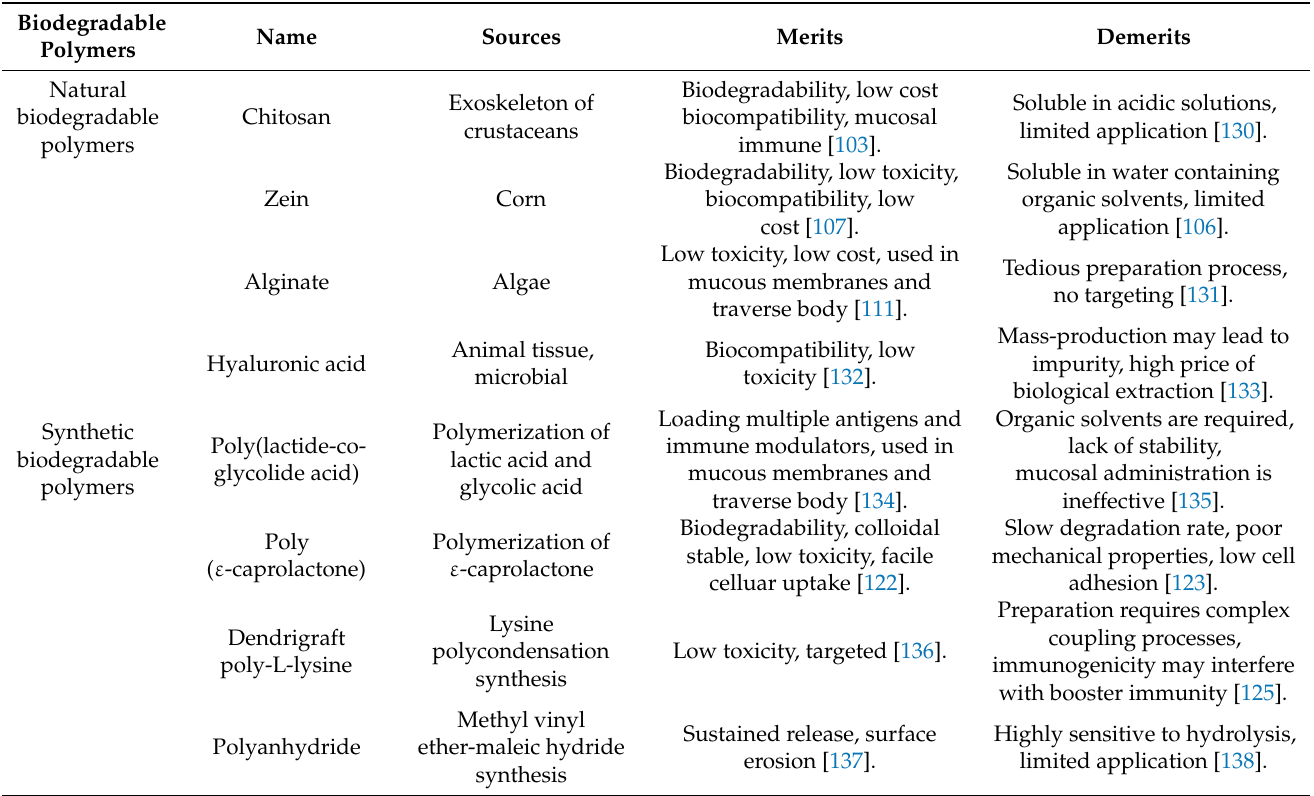
Table 1. Biodegradable polymers: sources, merits, and